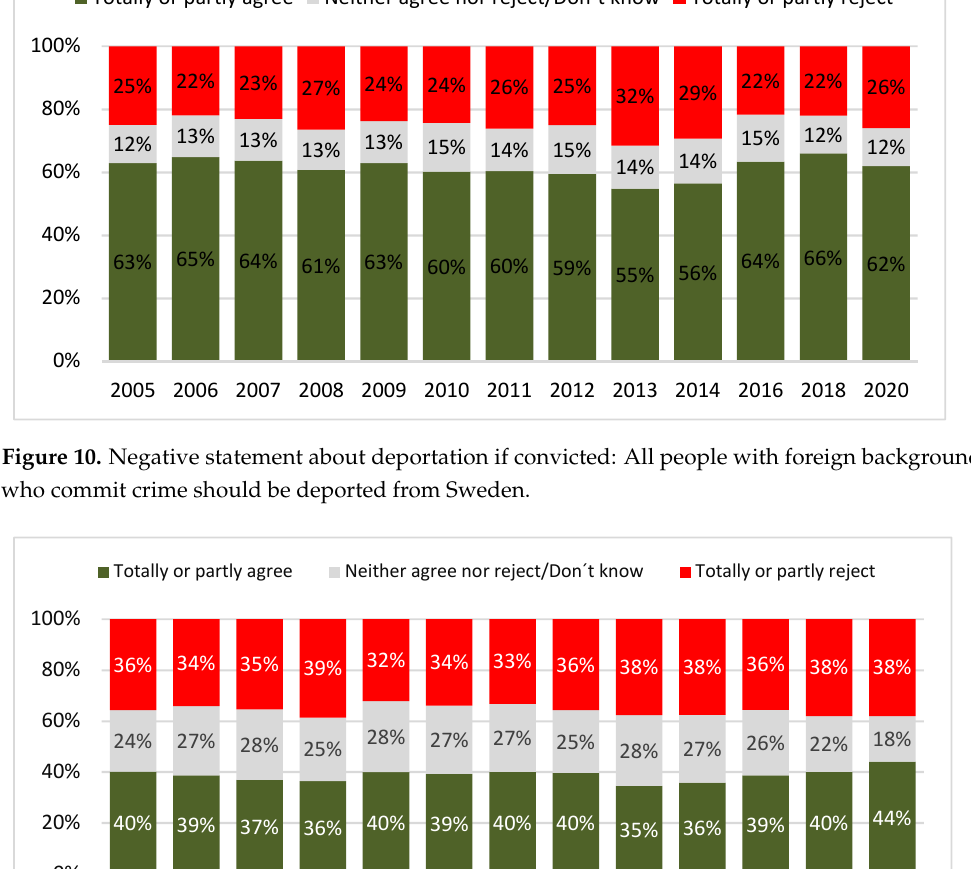
Figure 10. Negative statement about deportation if convicted: All people with foreign background who commit crime should be deported from Sweden.